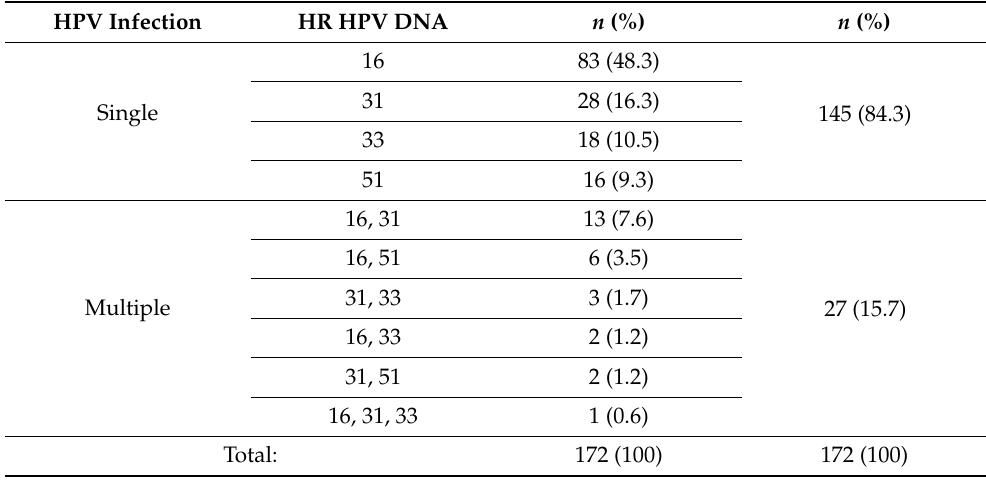
Table 3. Cervical cytology and age of female patients diagnosed with the most prevalent HR HPVs. Most Prevalent HR-HPV-DNA-Positive Women n (%)